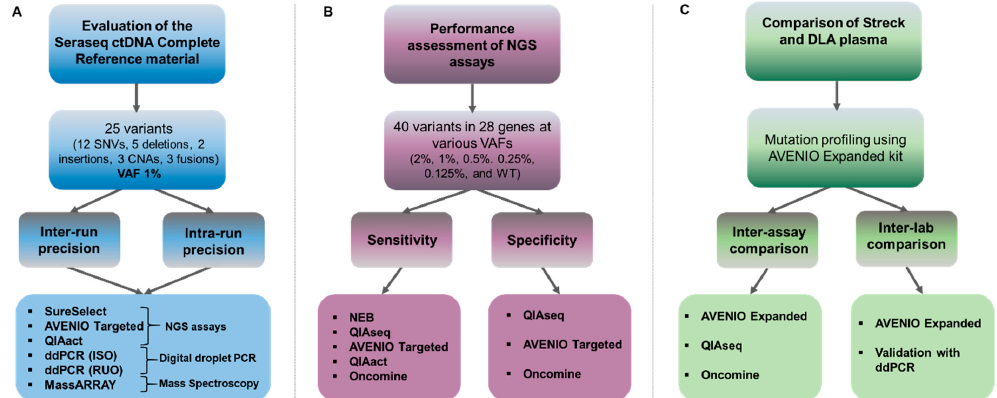
Figure 1. Experimental setup to assess commercially available reference material and mutation analysis kits. ( A ) Multicenter evaluation of the Seraseq ctDNA Complete reference material using three NGS panels (a custom SureSelect design [Agilent], the AVENIO Targeted kit [Roche], and the QIAact Lung UMI Panel [QIAGEN]), two digital droplet PCR assays (ddPCR) (one ISO15189 certified [ISO] and one research use only [RUO], and the MassARRAY (UltraSeek lung panel [Agena]). Intra-run precision was evaluated by testing the VAF1% reference material in triplicate in a single complete mutational analysis workflow. Inter-run reproducibility was assessed by testing the sample in three separate mutational analysis workflows. ( B ) Using the Seraseq ctDNA reference material v2, five commercially available mutation analysis assays targeting clinically relevant genes were tested with respect to sensitivity and specificity. ( C ) Assessment of Diagnostic LeukApheresis (DLA) for inter-assay comparison at a single site (MUG) and for inter-laboratory comparisons at two sites using the AVENIO Expanded kit (MUG and UMCG). A subset of variants was validated using ddPCR.